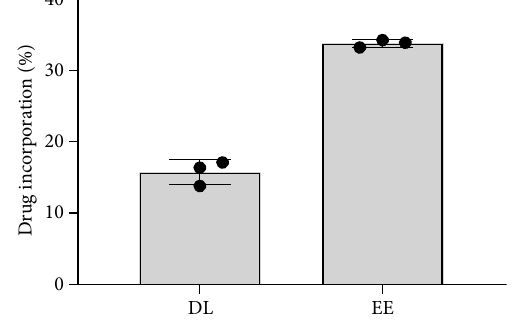
Figure 4: Drug loading and encapsulation e ffi ciency of melatonin- loaded nanoparticles